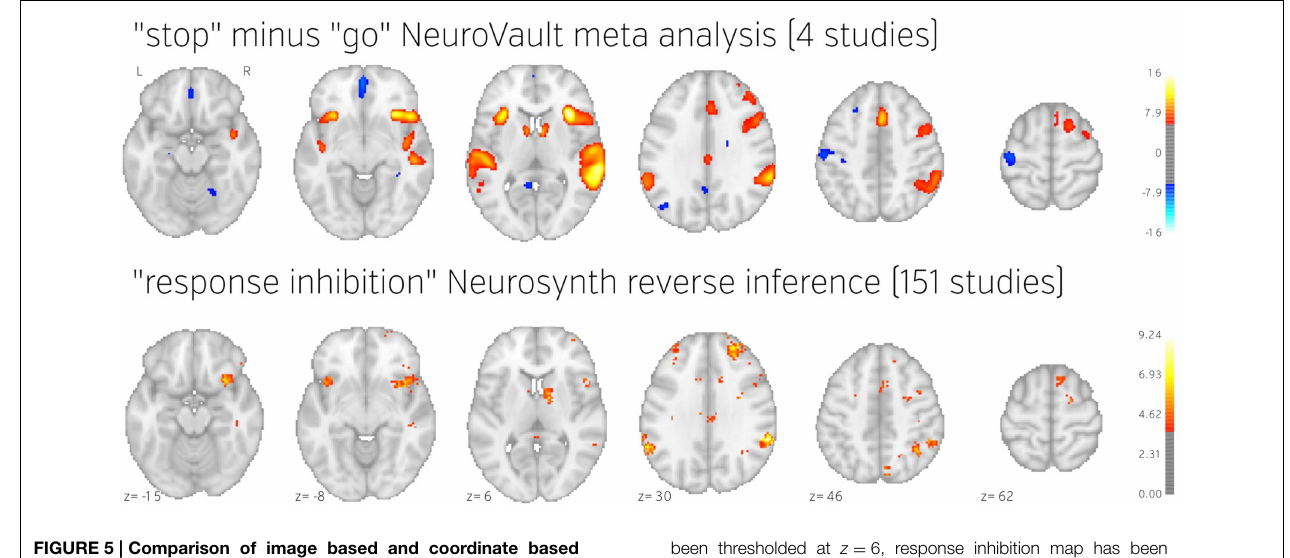
FIGURE 5 | Comparison of image based and coordinate based meta analysis of response inhibition. Meta analysis based on unthresholded statistical maps obtained from NeuroVault (top row) managed to recover the pattern of activation obtained using traditional methods despite including much fewer studies. NeuroVault map has